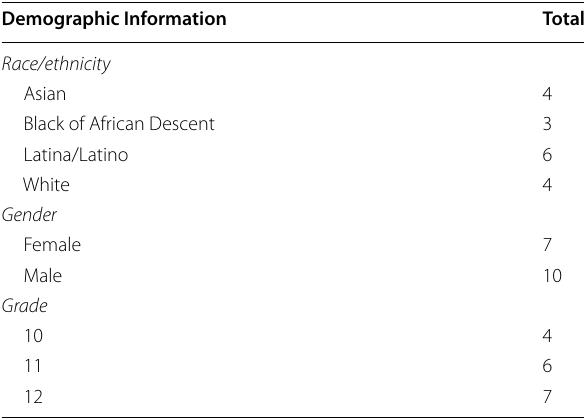
Table 1. Self-reported race, gender, and grade level of program participants of the landscape genetics research team (n